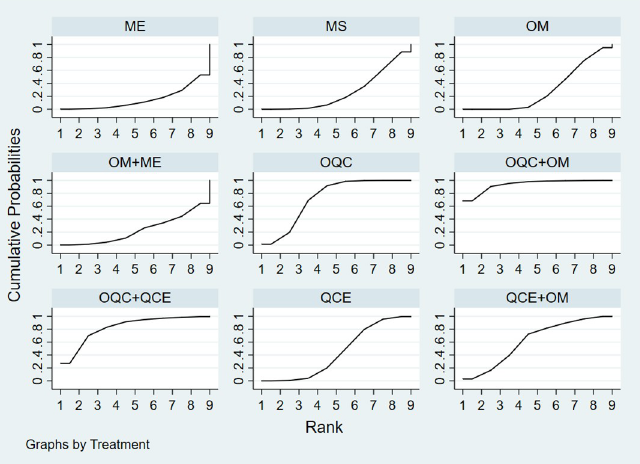
Fig 4. Surface under the cumulative raking curve of clinical response.